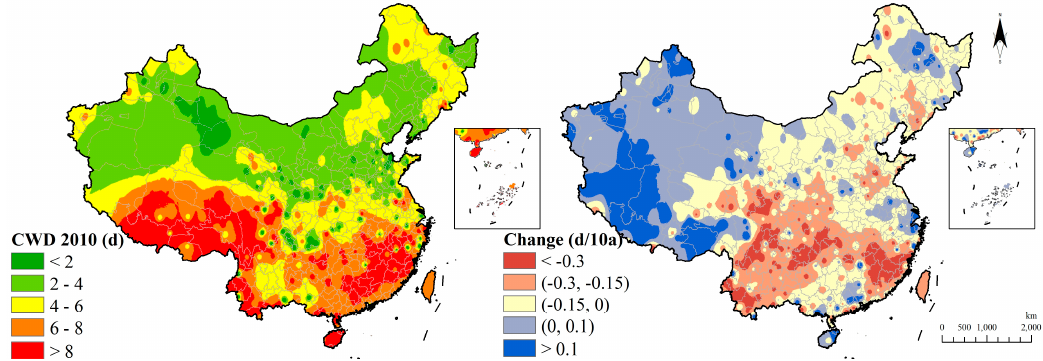
Figure 13. Consecutive wet days indicator distribution and change.